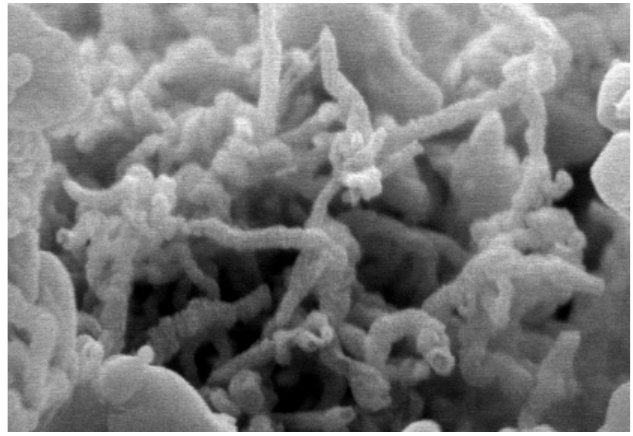
Figure 10. Field emission scanning electron microscopy (FE-SEM) of NiLaMgCa spent catalyst .